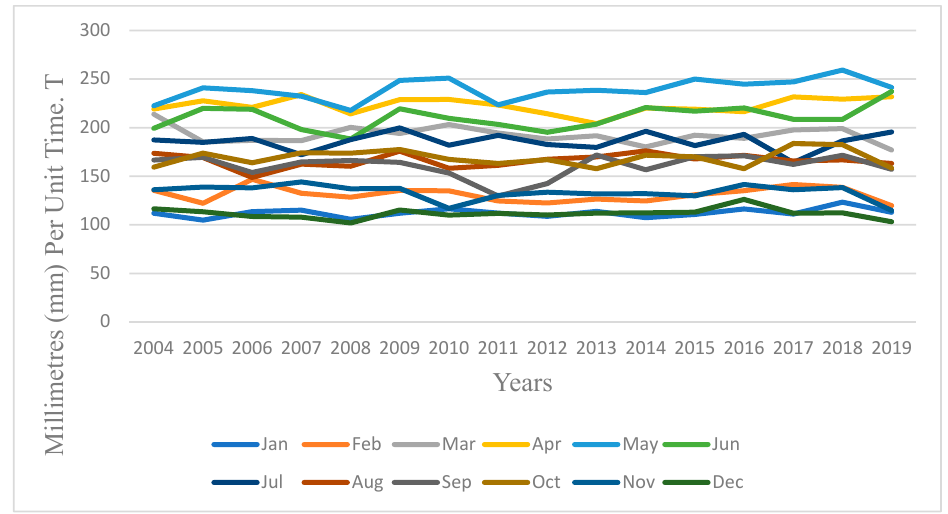
Figure 5. Annual cycle of the precipitation the input data starts from 2004 to 2019.